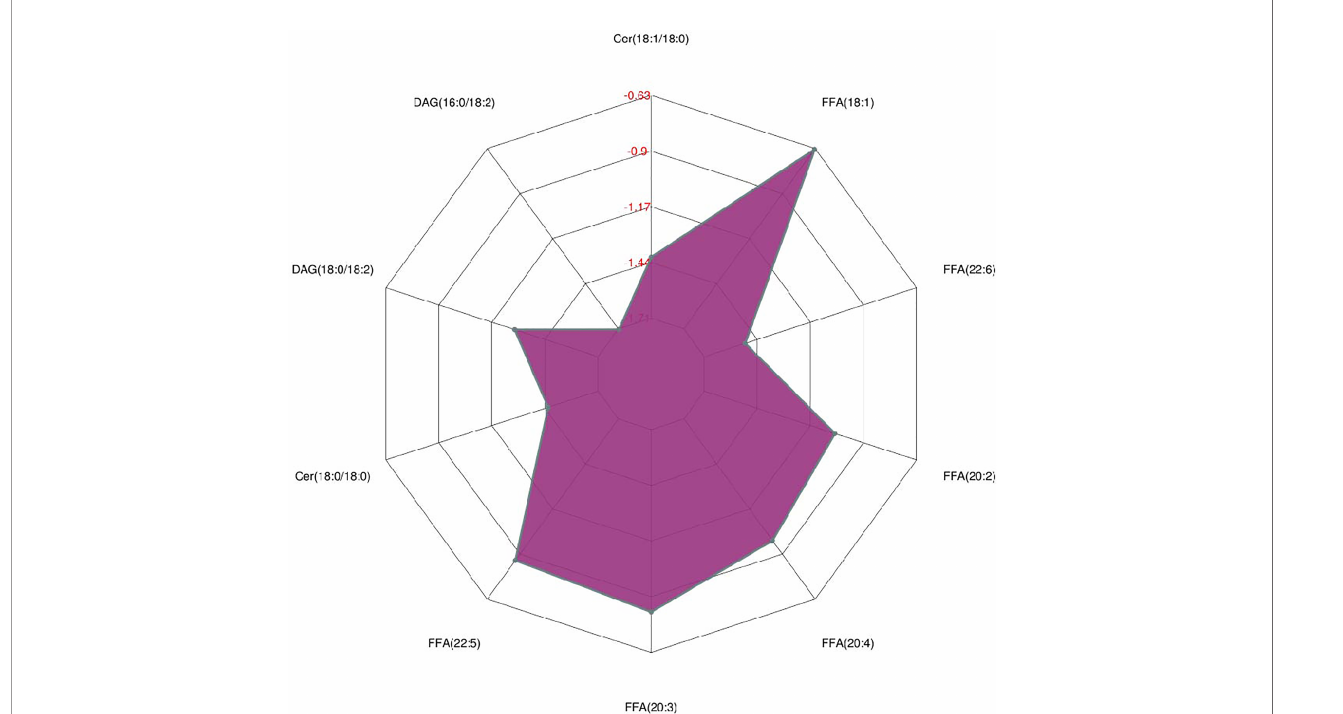
FIGURE 4 | Radar chart analysis for the treatment (KS) vs control (HC) groups.